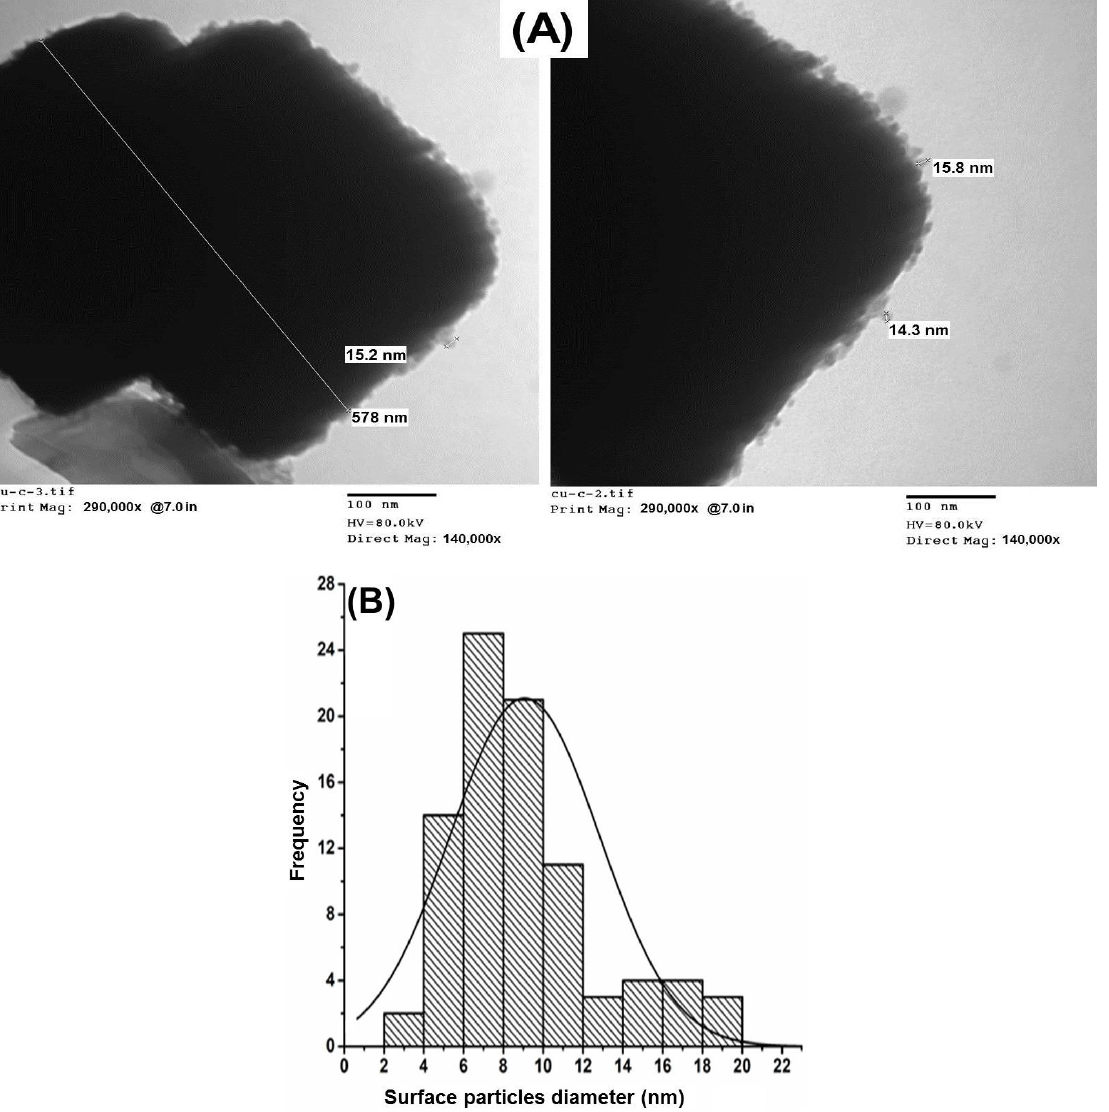
Figure 4. ( A ) TEM images of Cu 2 ONPsC@G and ( B ) diameter distribution of particles (Cu 2 ONPs) at cube surface derived from TEM.